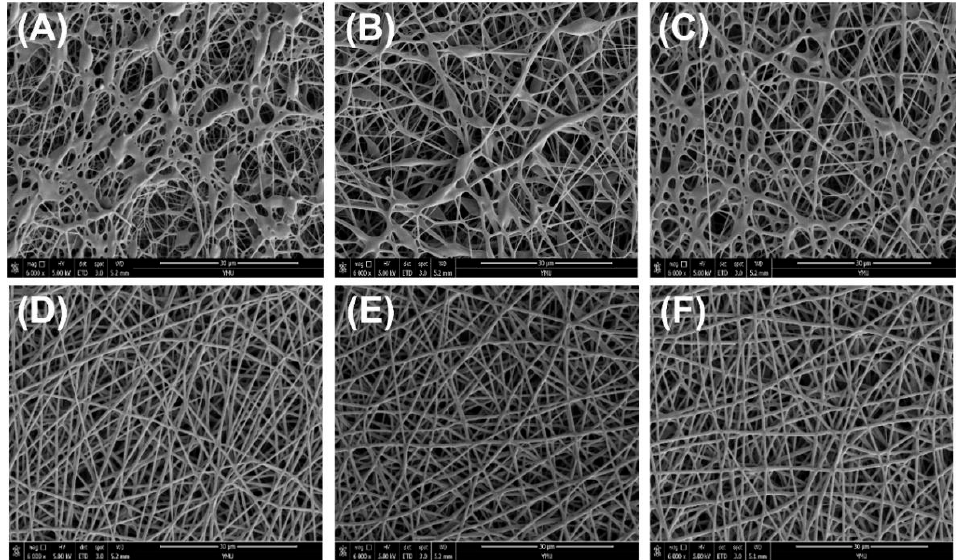
Figure 1. SEM image of electrospun fibre membrane. ( A ) PLLA, ( B ) PLLA/PTMC (9:1), ( C ) PLLA/PTMC (8:2), ( D ) PLLA/PTMC (7:3), ( E ) PLLA/PTMC (6:4) and ( F ) PLLA/PTMC (5:5) (scale bar: 30 μ m).